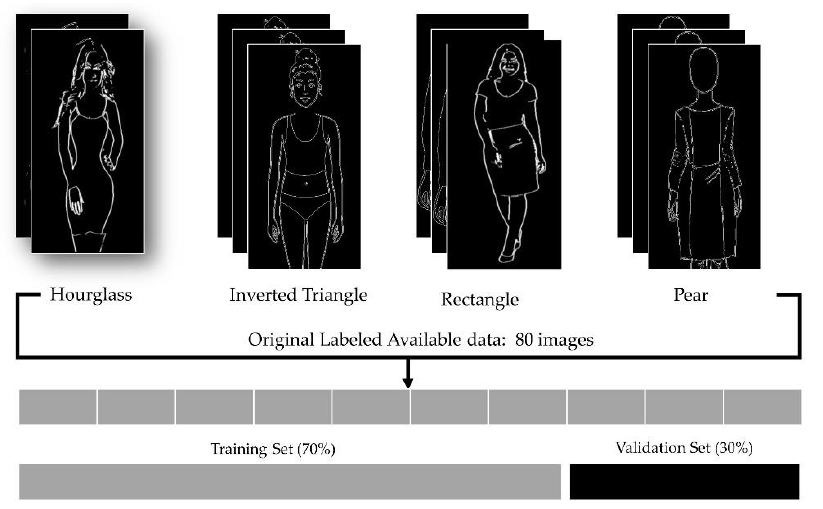
Figure 4. Training and validation datasets: 30% of the data were held out for validation.